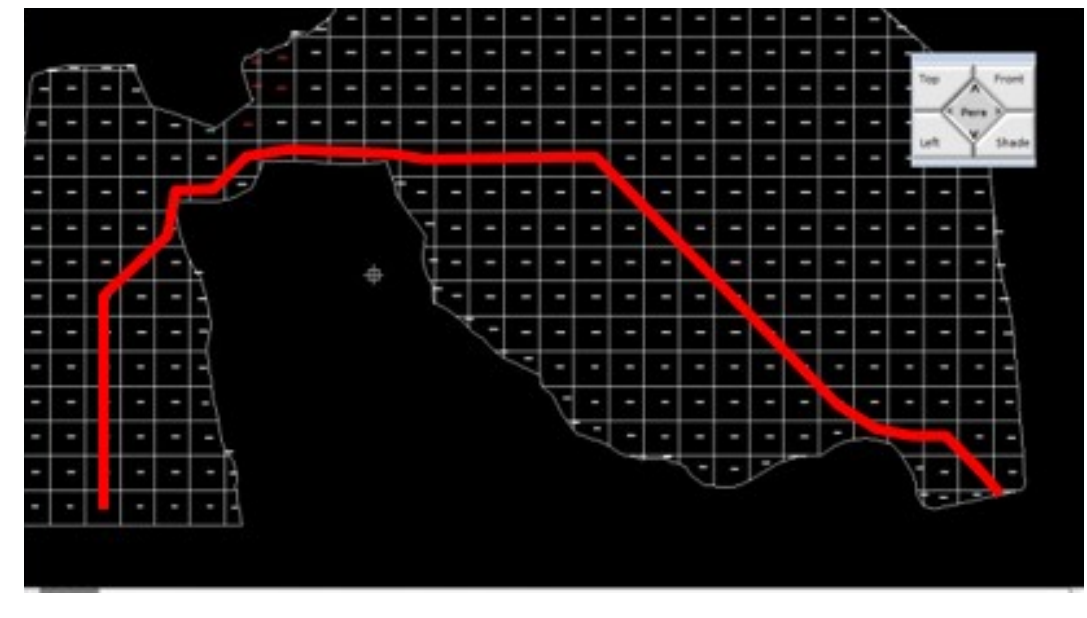
Figure 7. Optimal Path.